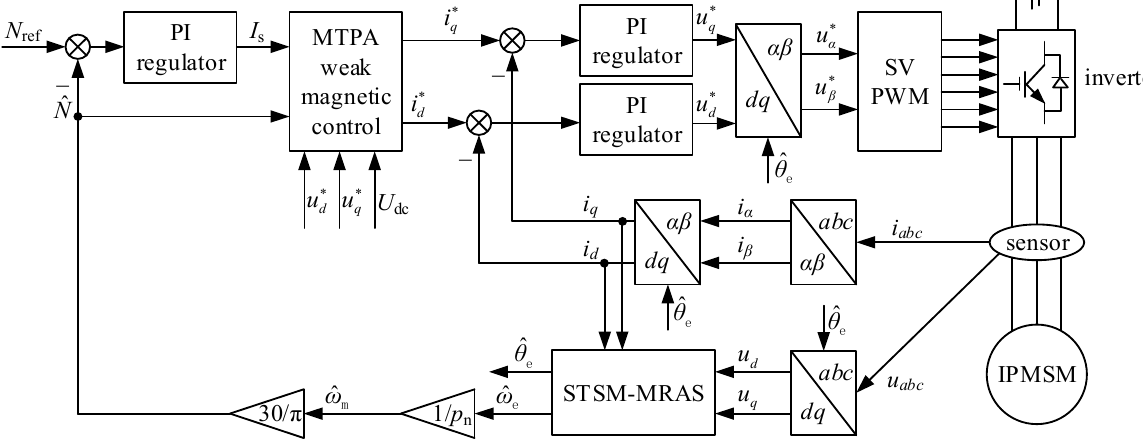
Figure 8. Block diagram of STSM − MRAS control system.